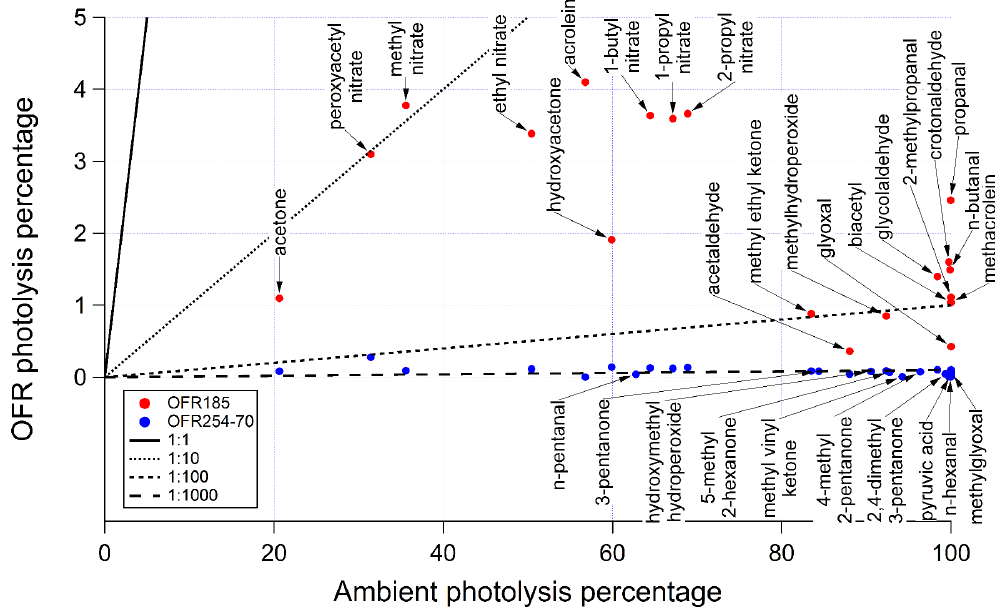
Figure 6. Ambient photolysis fractions of secondary species in a week (calculated from photolysis rates reported in Hodzic et al., 2015) vs. photolysis fractions of those species in OFR185 and OFR254-70 when reaching the same photochemical age (ambient OH concentration of 1 . 5 × 10 6 moleculescm − 3 assumed) under conditions of 44% relative humidity (water vapor mixing ratio of 1.4%) and 25s − 1 initial OHR ext . If the points of a certain species for both OFR185 and OFR254-70 are available, the species name is tagged on the OFR185 point (downward arrow); otherwise it is tagged on the OFR254-70 point (upward arrow). The 1:1, 1:10, 1:100, and 1:1000 lines are also shown for